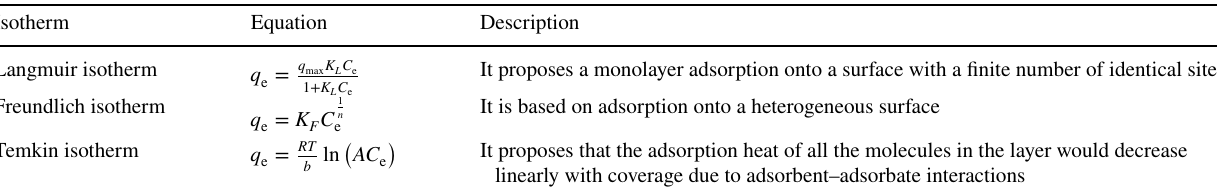
Table 1 Adsorption equilibrium isotherms Isotherm